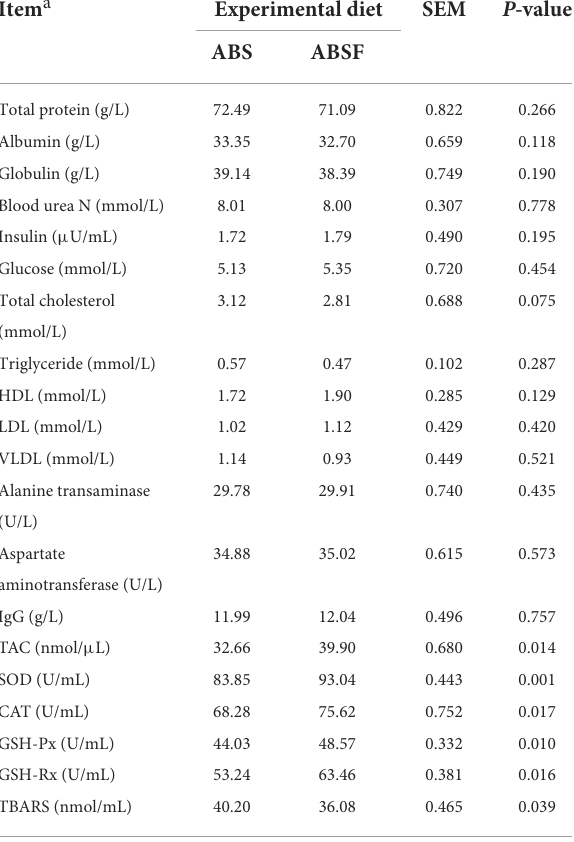
TABLE 4 Rumen fermentation of goats fed a total mixed ration supplemented with anthocyanin-rich black cane silage (ABS) or anthocyanin-rich black cane silage treated with ferrous sulfate heptahydrate (ABSF).